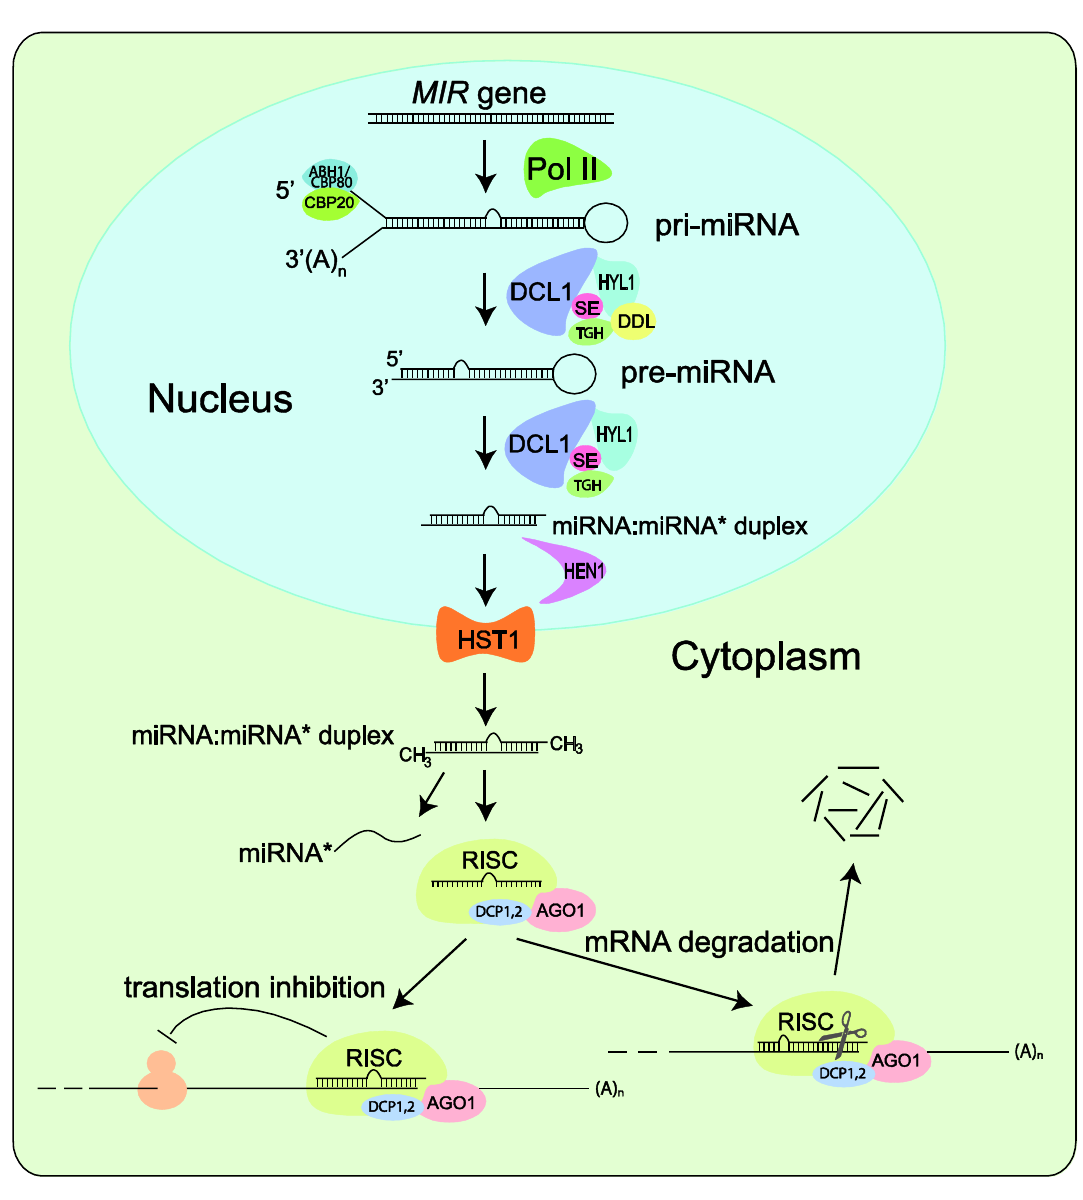
Figure 2. Simplified model of miRNA biogenesis in plants. MIR genes are initially transcribed by Pol II into pri-miRNAs that fold back to form hairpin structure. Splicing and further processing in nuclear involve the interactive functions of HYL1, DDL, TGH and SE and of the cap-binding proteins CBP20 and CBP80. Pri-miRNAs and pre-miRNAs are sequentially processed by DCL1 to yield one or several phased miRNA/miRNA* duplexes, which are methylated by HEN1 and transported to the cytoplasm by HST1. The miRNA is selected and incorporated into dedicated AGO1-containing RISC that directs translation inhibition or cleavage of the target mRNA